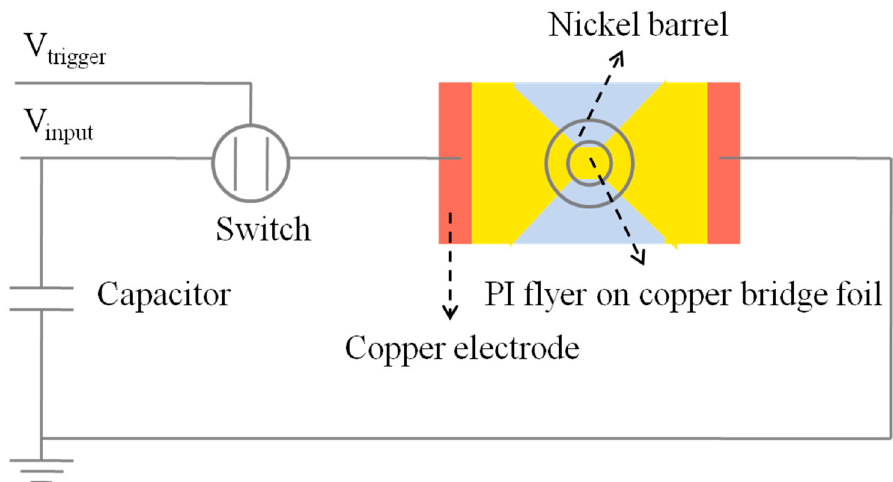
Figure 3. Schematic diagram of the electric explosion device.